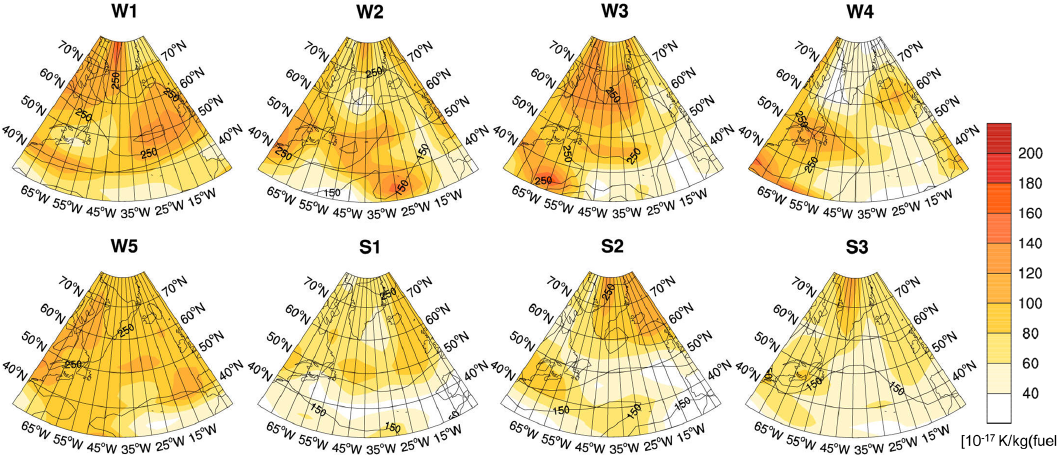
Figure 12. H 2 O climate change functions for the eight individual weather situations and an emission at 12:00UTC at 250hPa. CCFs for other pressure levels and times investigated in this study are presented in the Supplement. The isolines show the height of the tropopause in hectopascals (hPa).